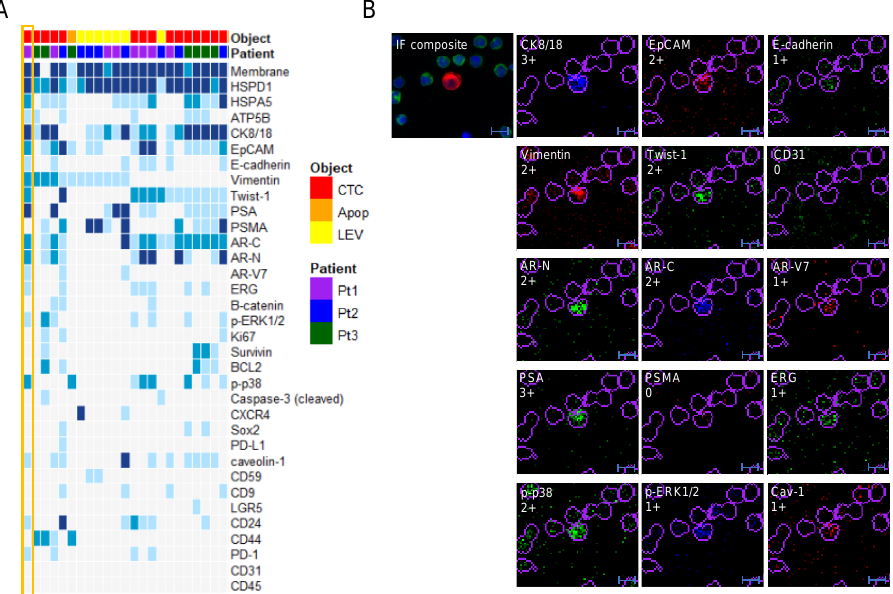
Figure 4. Concurrent expression of EMT and epithelial markers detected by IMC analysis. ( A ) Subset of objects positive for EMT markers Twist-1 and Vimentin, most with concurrent expression of epithelial markers (EpCAM, CK8/18, E-cadherin). Selected individual channels from the CTC marked in ( A ) is shown in ( B ). In addition to the channels shown, this particular cell scored positive for HSPD1 (3+), HSPA5 (2+), ATP5B (1+), PD1 (1+) and CD24 (1+). CD31 (negative) was included to support that Vimentin-expression cannot be explained by endothelial origin. Scale bar is 10 µ